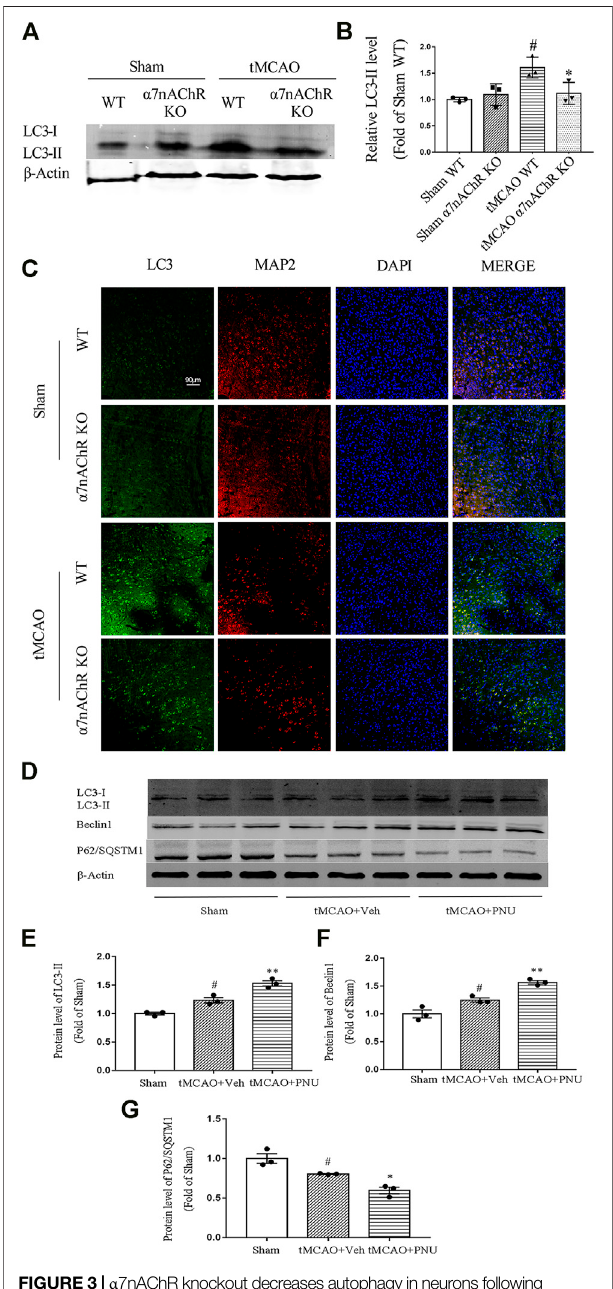
FIGURE 3 | α 7nAChRknockoutdecreasesautophagyinneuronsfollowing tMCAO. Wild-type (WT) mice, α 7nAChR knockout (KO) mice, and C57BL/6 mice were subjected to sham or tMCAO surgery. Brains were collected at 24 h after tMCAOsurgery.Thepenumbralzoneofthebrainswasisolated,andprotein levelsofLC3,Beclin1,andP62/SQSTM1weredetectedbyWesternblot.Paraf fi n- embeddedcoronalbrainsectionswerepreparedforimmuno fl uorescencestaining ofLC3,MAP2,and DAPI. (A,B) LC3levelwasincreased after tMCAO inWTmice comparedwiththatintheshamgroup;however, α 7nAChRKOmicealleviatedthis effect. n (cid:2) 3foreachgroup. # p < 0.05vs . ShamWT,* p < 0.05vs . MCAOWT. (C) Representative images of immuno fl uorescence microscopy. Scale bar, 90 μ